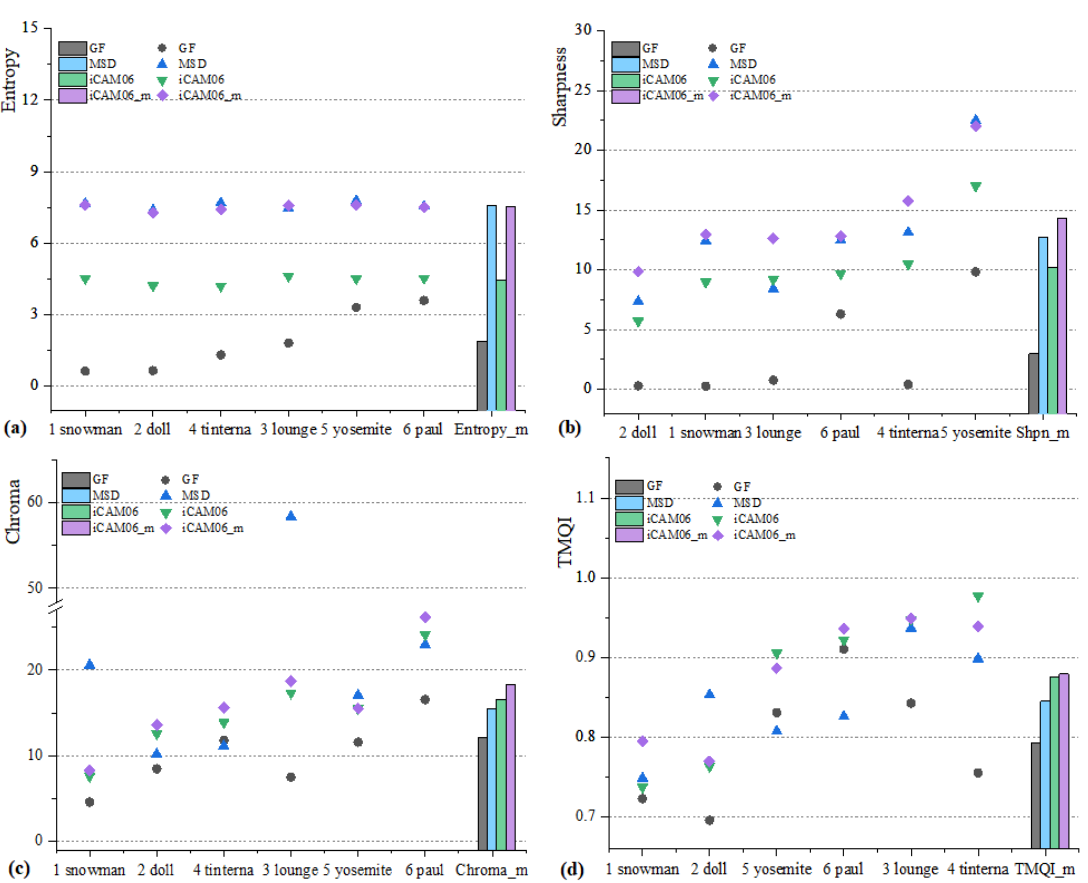
Figure 6. Assessment results of each image from 4 IQAIs. ( a ) The IE distribution of each image processed by 4 TMOs and the mean entropy of 4 TMOs. ( b ) The IS distribution of each image processed by 4 TMOs. ( c ) The IC distribution. ( d ) The TMQI distribution.